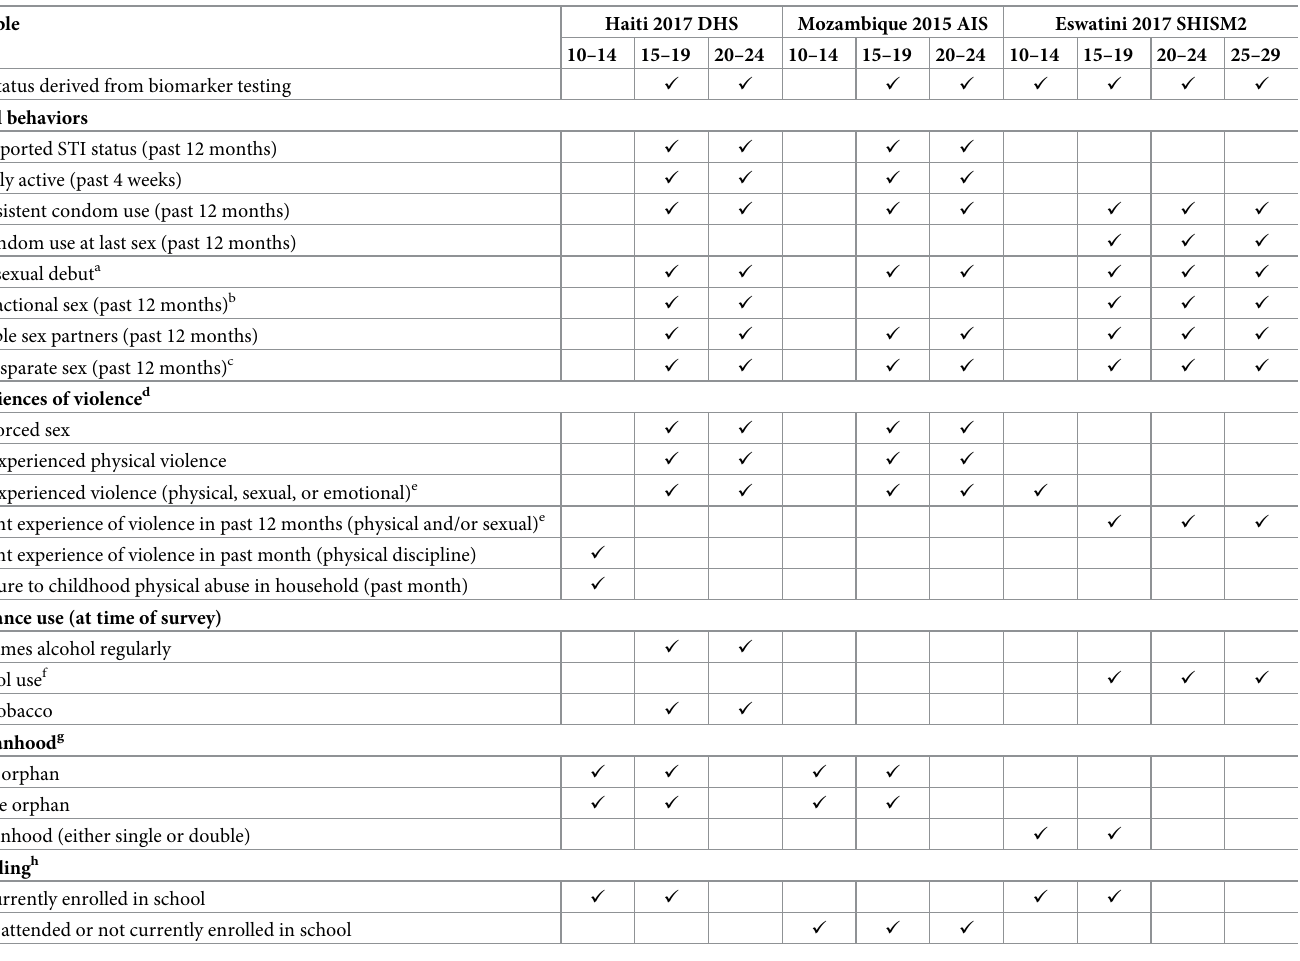
Table 1. Study variables by survey and age